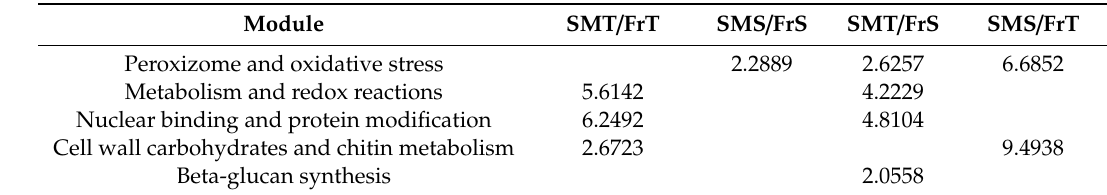
Table 1. Group enrichment scores for modules di ff erentially regulated for cross-time comparisons within the same RIL. ( p -value significant at α = 0.05).